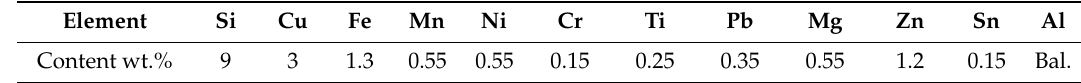
Figure 2. Flow diagram—Preparation of powder coating. Table 1. Chemical composition of AlSi 9 Cu 3 .